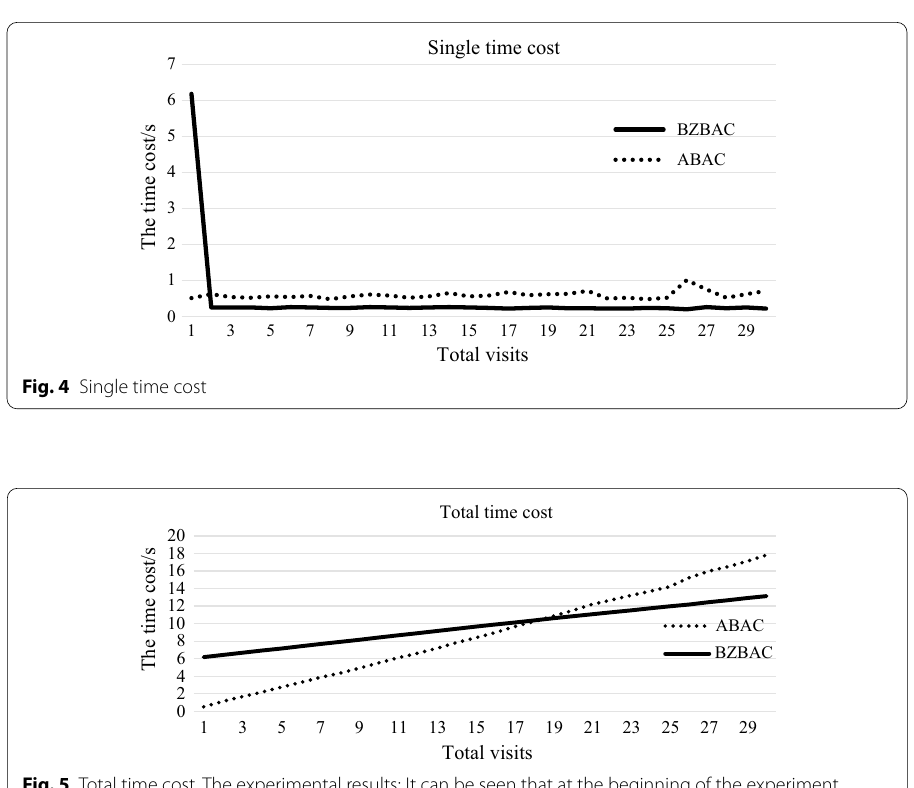
of linear growth. Since BZBAC has completed the generation of ZKToken, subsequent access time is only spent on the verification of ZKToken, so the growth of running time is relatively flat. Although ABAC has a lower cumulative time consumption than BZBAC for previous visits, it gradually has a higher time consumption than BZBAC after the 19th of this access. Thus, the BZBAC model can improve access efficiency and reduce time cost in the case of multiple accesses. If only a few visits are made, the time cost of this model is still relatively high due to the need for trust setting. How- ever, considering reality, users will often visit the same device multiple times rather than just several times. Also, compared with the time required for each visit, users are more inclined to prepare for the subsequent quick access by setting the first time for a longer time. Therefore, in general, the accumulated time cost of BZBAC is reduced and the user’s experience effect is improved.